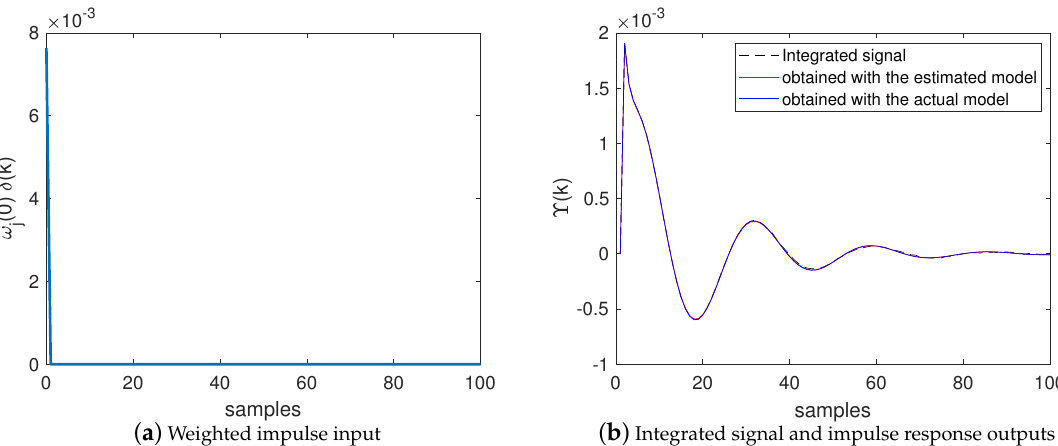
Figure 13. Input and output signals used by the BSA in Algorithm 3 to estimate M ( z ) considering the model defined in